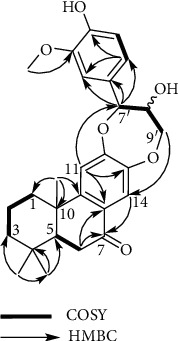
Key COSY and HBMC correlations for compound 3.